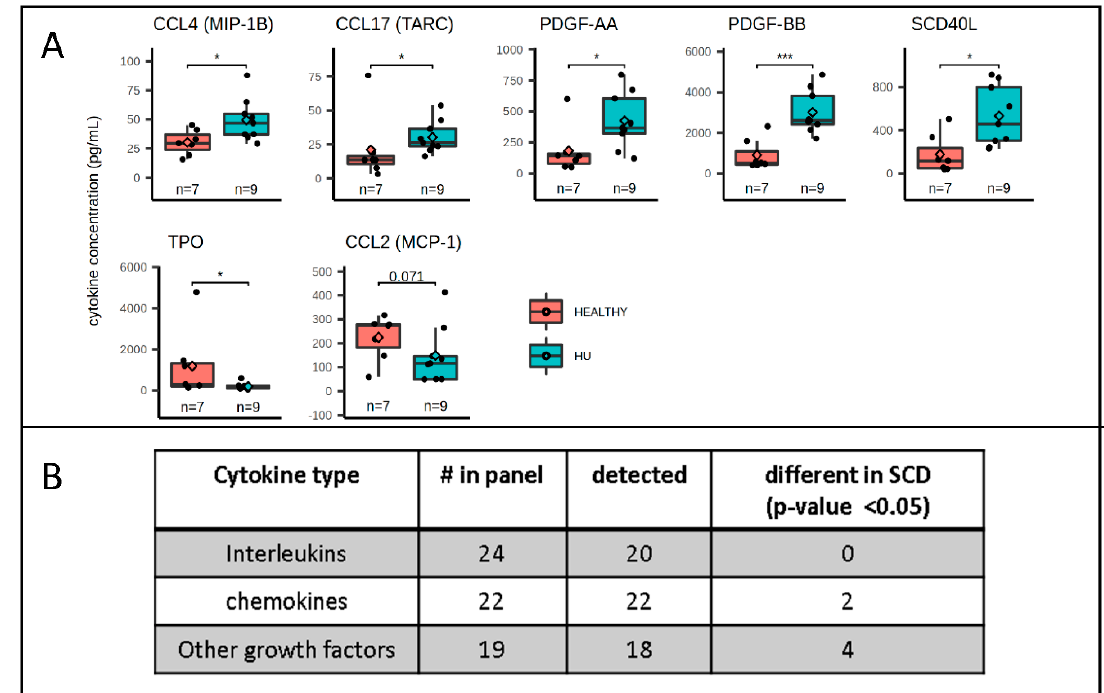
Figure 3. Concentrations of cytokine in the plasma of SCD and healthy individuals. ( A ) Boxplots summarizing the concentration of the 7 cytokines t present at significantly different concentrations in the plasma of the SCD patients compared to the controls. The box outlines the first and third quartiles. The horizontal bar represents the median; the diamond represents the mean. Significance was calculated using the Wilcox test (with FDR correction). * p ≤ 0.05; *** p ≤ 0.001. ( B ) Global results of the cytokine array. Plasma concentration of 65 cytokines in seven healthy controls and nine SCD patients on HU was assessed using FACS-based multiplex array methods.